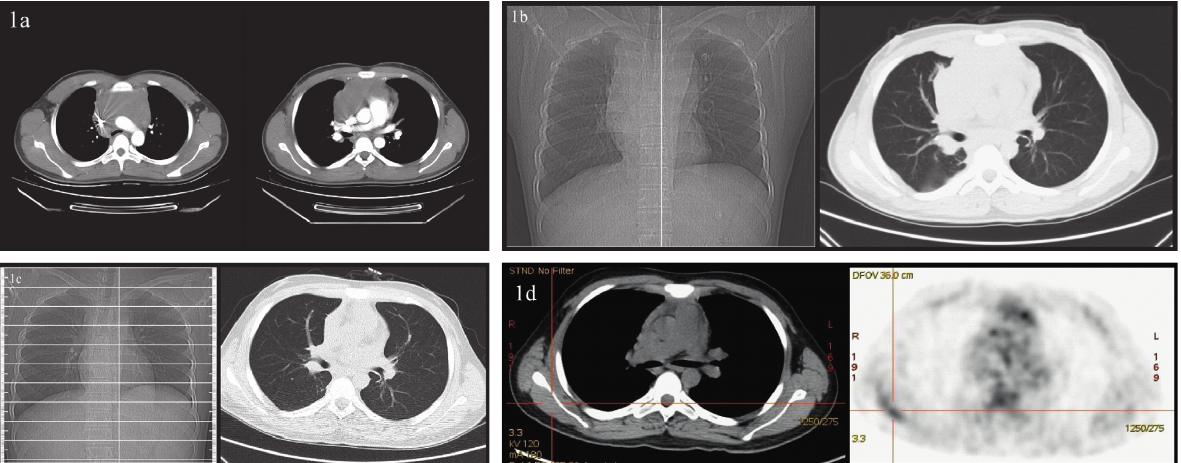
Figure 1: Results of chest CT or PET-CT scan.